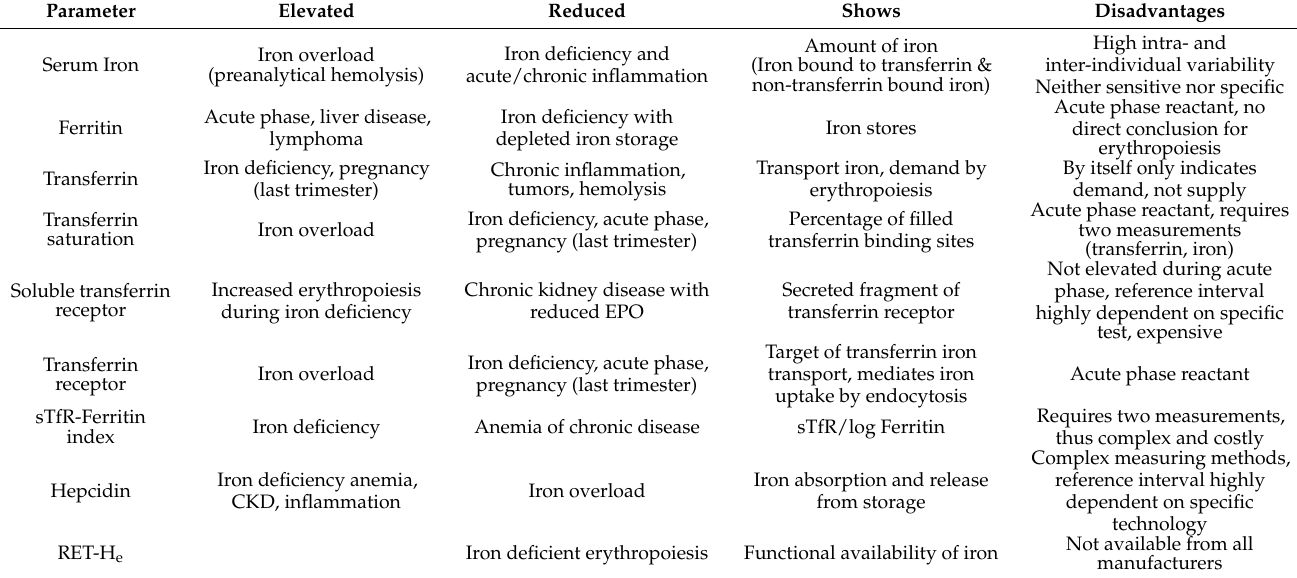
Table 1. Overview of iron deficiency